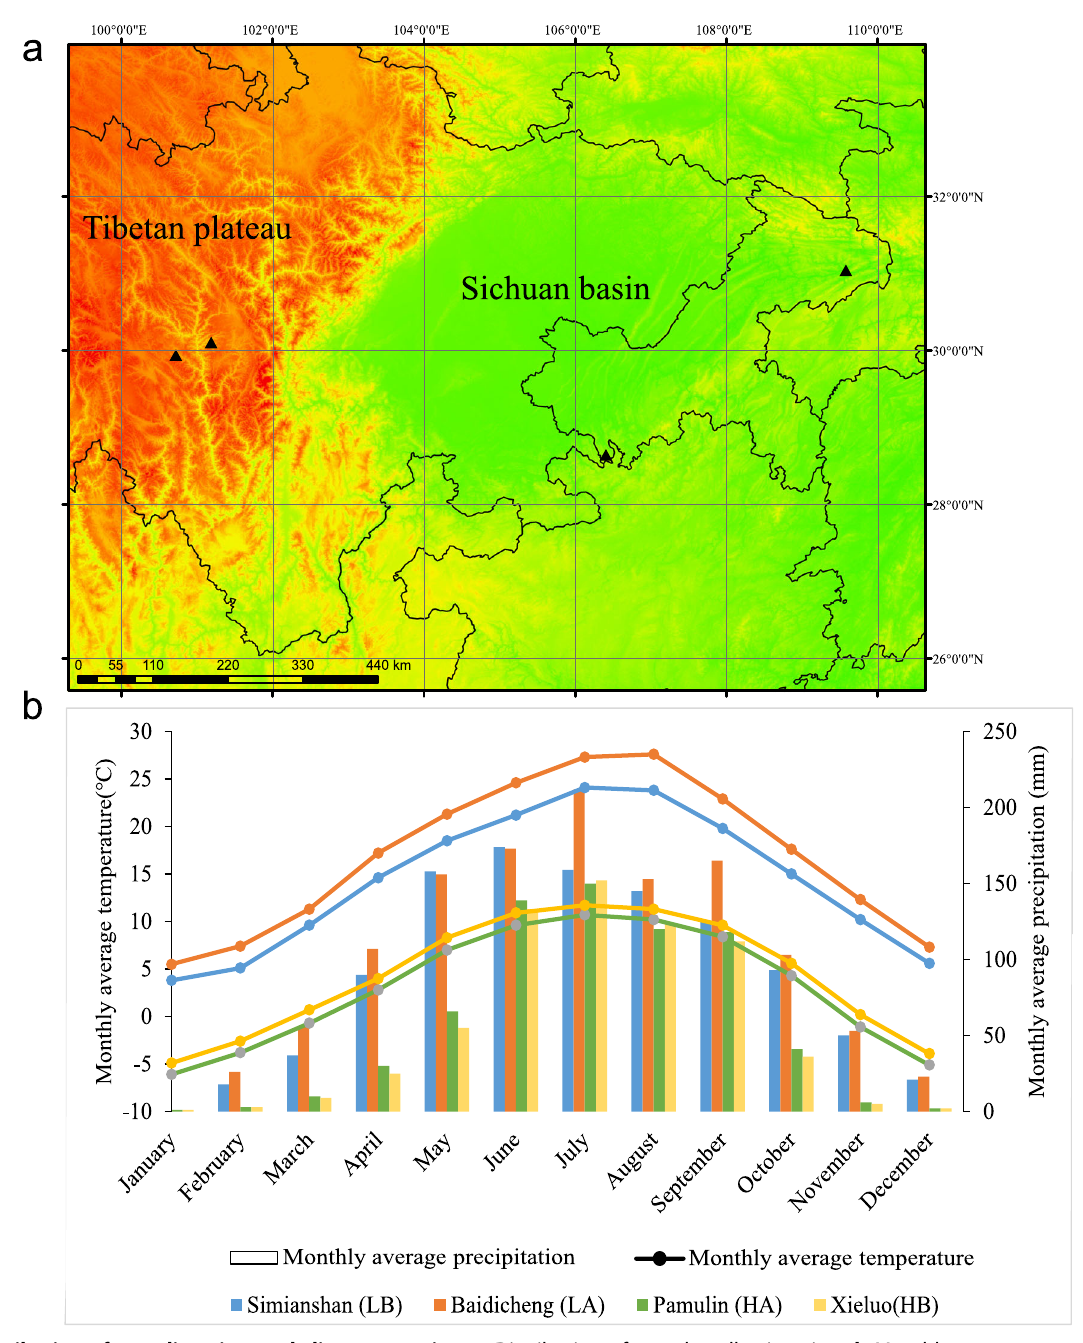
Fig. 8 Distribution of sampling sites and climate overview. a Distribution of sample collection sites. b Monthly average temperature and precipitation data for 1970 – 2000 at the sampling site obtained based on WorldClim (version 2.1). The boundary data comes from the data published by China National Basic Geographic Information Center. Triangles represent sample and stored at -80 °C until analysis. There was no direct contact the total number of RM groups sampled at the four sites ranged with RM during fecal collection, and our study had no impact on from 40 to 50, and all sampled individuals were considered adult the health or welfare of RMs. individuals based on follow-up observations and comparison of Samples collected from the four locations were analyzed for stool size. After defecation by the wild RMs, fecal samples were microsatellite molecular markers for individual identi fi cation and immediately collected with sterile gloves then stored in liquid for SRY/ZFX genes for sex determination. The partial SRY gene nitrogen and transported to the laboratory. The samples for DNA (364 bp) on the Y chromosome and the partial ZFX gene (183 bp) preparation and metabolome detection for metagenomic sequen- on the X chromosome were used for sex determination. The cing were taken from the center of the fecal samples under sterile primers were designed by Primer Premier 5 based on sequences conditions, while samples for DNA preparation for individual in the GenBank database (accession numbers AF284311 and identi fi cation and gender identity were taken from the surface. XM_028842412). The six microsatellite loci used for individual After collection, the samples were transported in liquid nitrogen